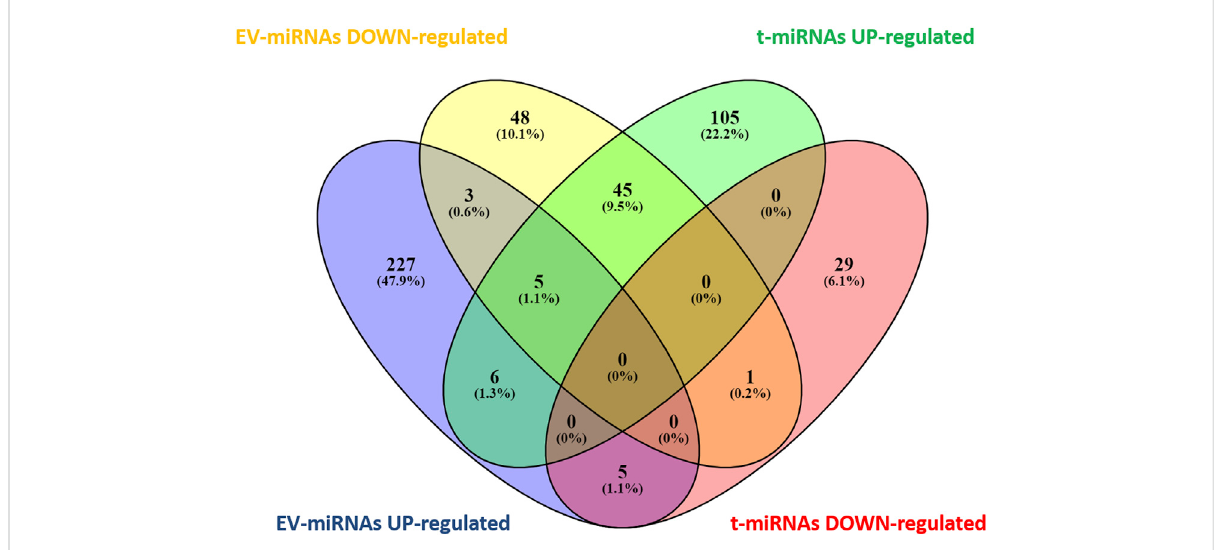
FIGURE 3 Venndiagramoftargetgenespredictedfort-andEV-miRNA.Graphicalrepresentationofcommon predictedtargetgenesbetweent-andEV- miRNAs. Venn diagram was based on comparison of the 161 target genes predicted for up-regulated t-miRNAs, the 35 targets predicted for down- regulated t-miRNAs, the 246 targets predicted for up-regulated EV-miRNAs, and the 102 target predicted for down-regulated EV-miRNAs. Venn diagram analysis was performed using Venny [(27)